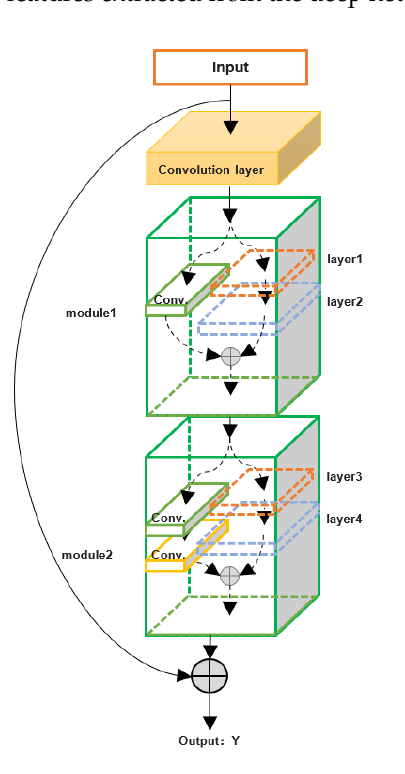
Figure 5. Improved ResNeXt residual